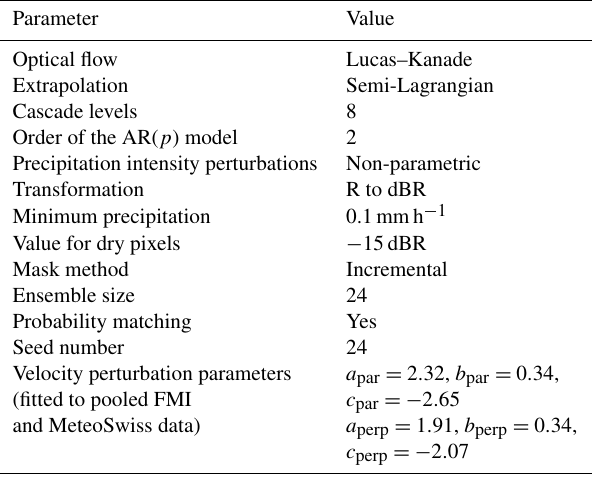
Table 5. The default configuration used in the experiments. Parameter